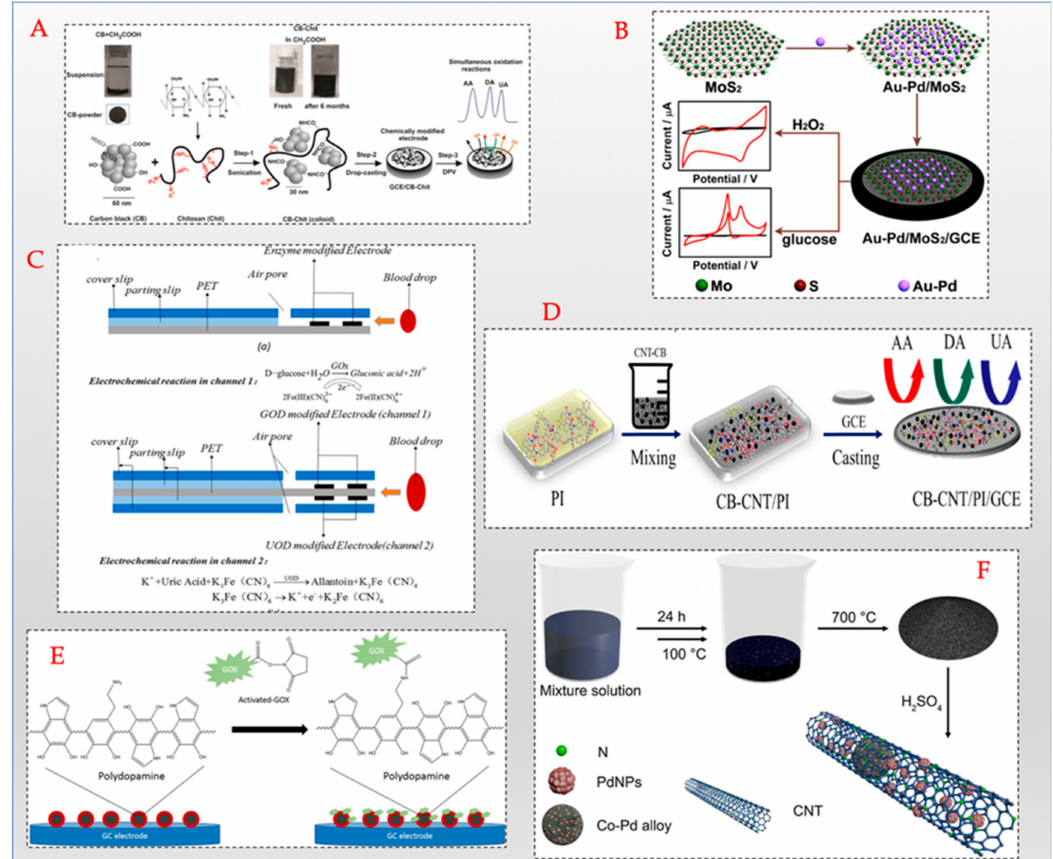
Figure 3. Schematic representation of di ff erent modification processes of working